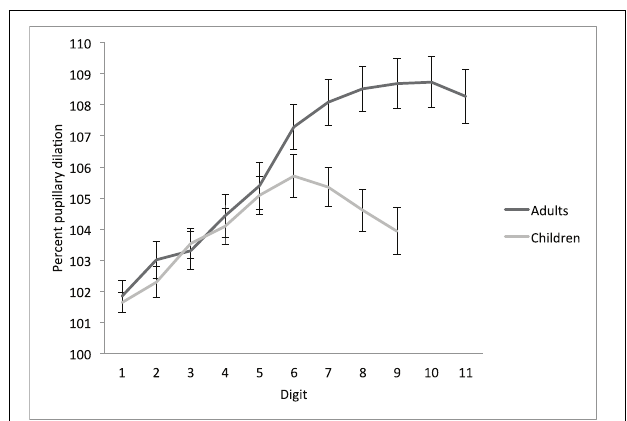
FIGURE 2 | Temporal dynamics of pupil dilation and constriction on the STM overload task. Mean percentage of pupil dilation for each digit relative to mean pupil diameter over the cue period (set to a starting point of 100%; Karatekin, 2004), by age group. Adults encoded four sequences of 11 digits each, and children encoded four sequences of 9 digits each. Error bars represent standard mean